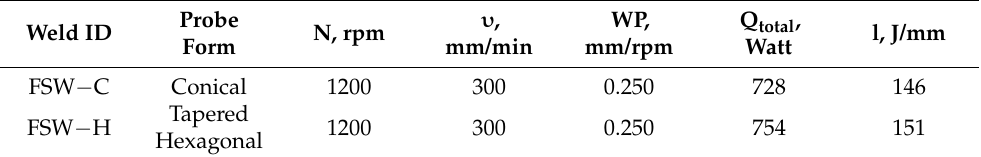
Figure 2. Tools for FSW with different probe profiles: ( a ) conical form; ( b ) tapered hexagonal form. Table 2. FSW matrix.